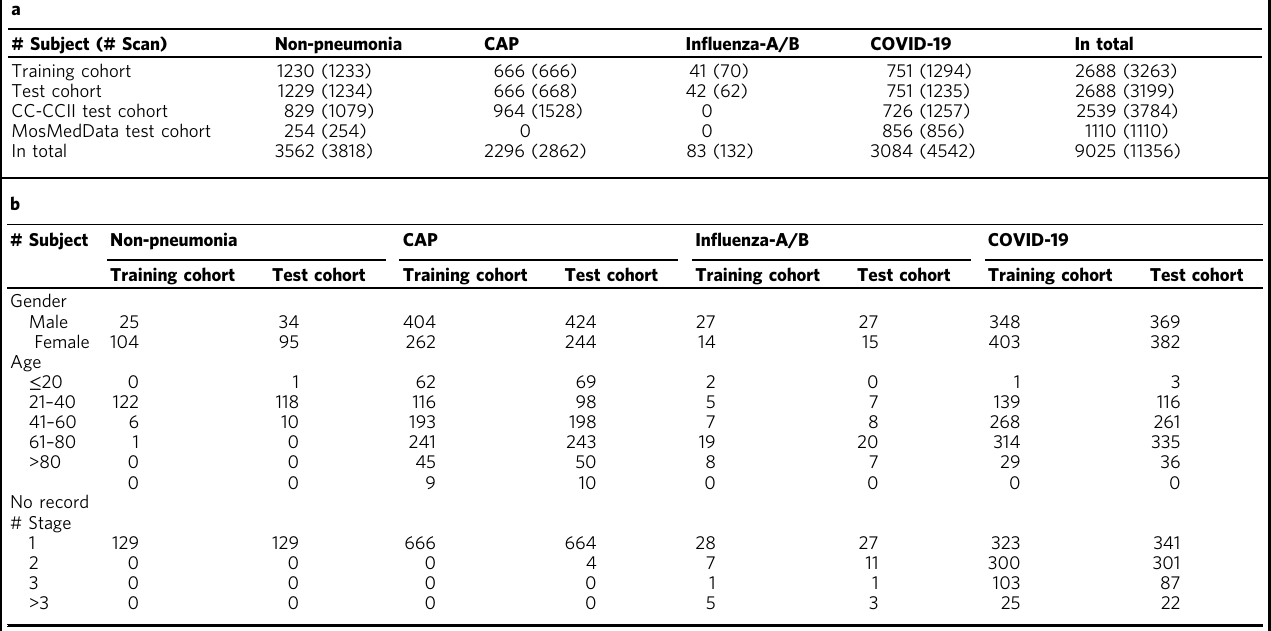
Table 1 Characteristics of patients from our datasets.